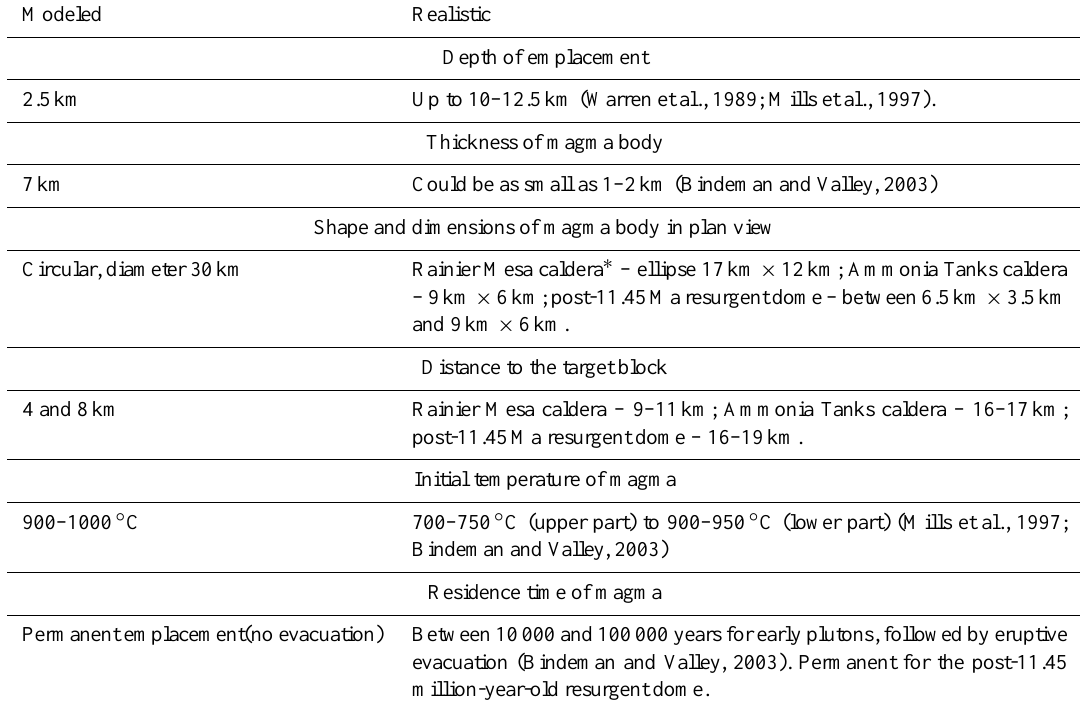
Table A2. Comparison of parameters used in thermal simulations of the MICH model by Marshal and Whelan (2001) and Whelan et al. (2008) with realistic parameters for the Timber Mountain volcanic